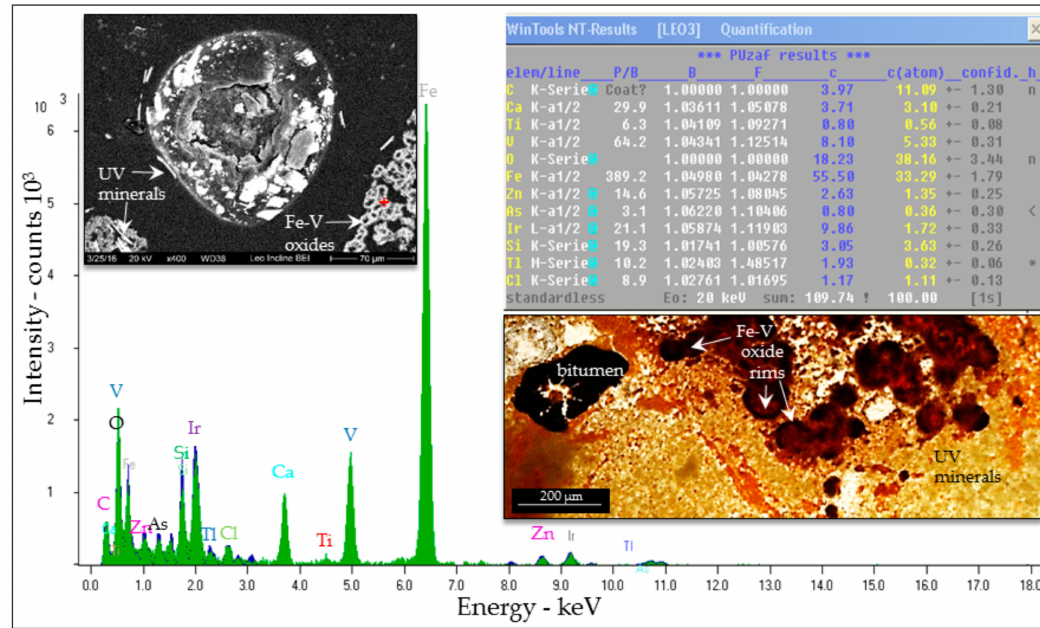
Figure A9. EDS spectrum collected from + in the BSE image above. Elements detected were C, Ca, Fe, V, Ti, Zn, As, Tl, Si, Cl and O. The sample was coated with Ir. Cl is likely from the epoxy for mounting the sample. Sample is a polished thin-section from a limestone breccia, Leo Incline area, LMD. The U-V minerals occur in close association with Fe-oxides and or hydroxides and bitumen. The black area in the image is an inclusion of bitumen. The red orange Fe-oxides, some with darker Fe-V rims show up well in plain polarized light as do the yellow to yellow green U-V